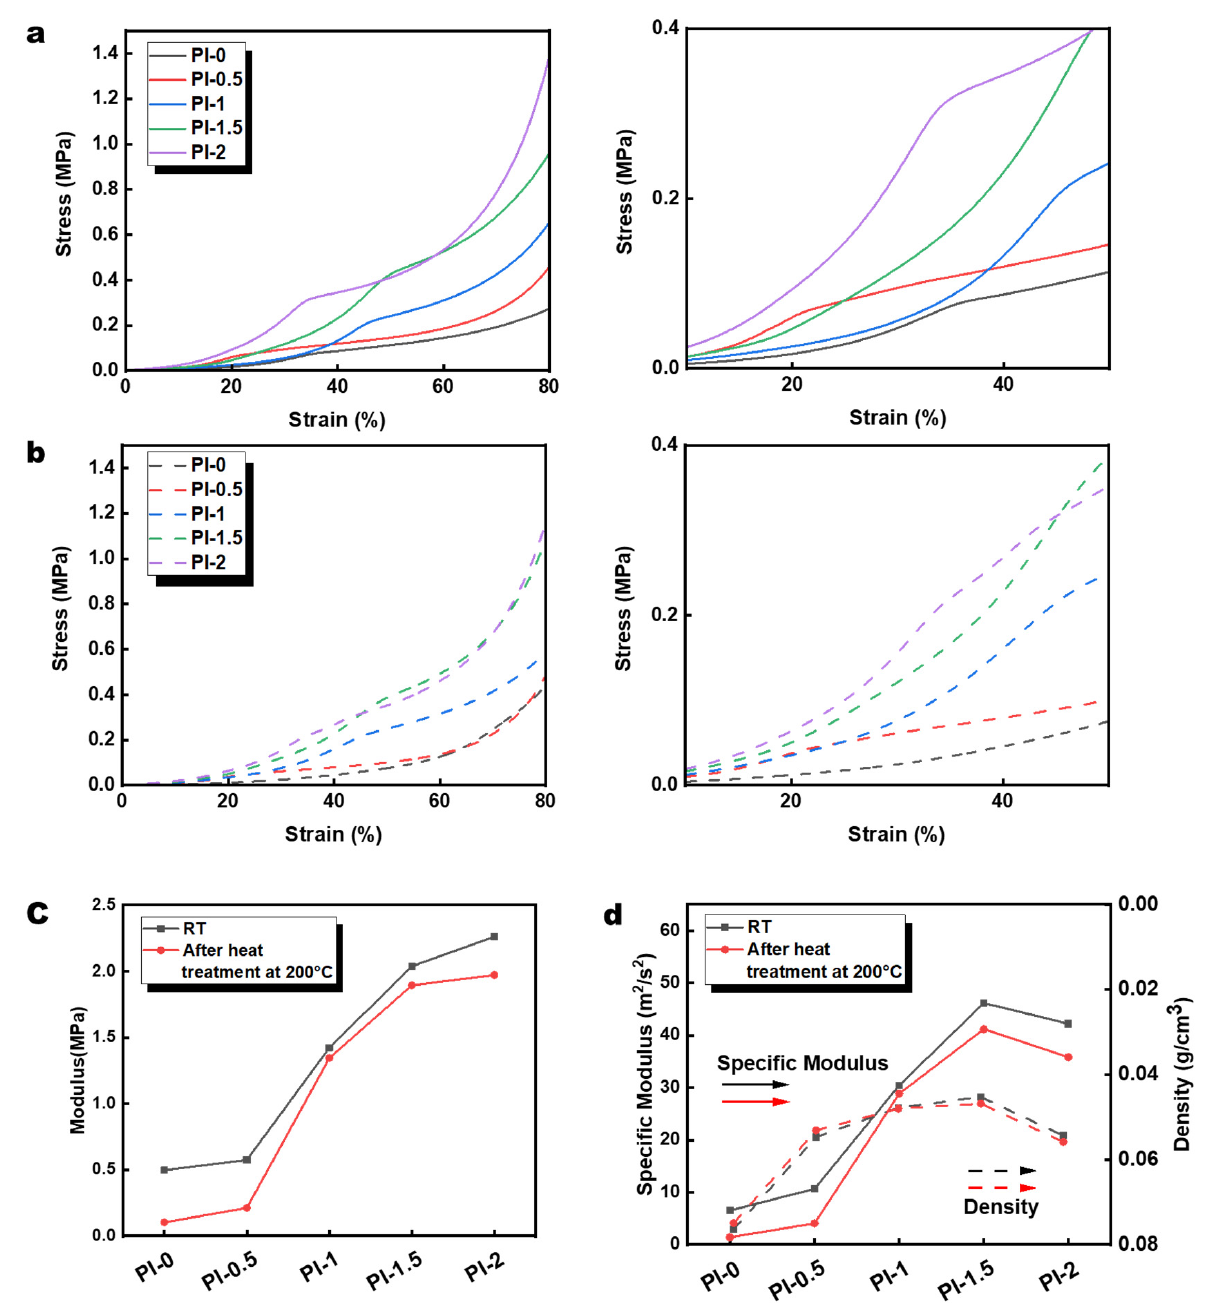
Figure 5. ( a , b ) The stress–strain curves, ( c ) Young’s moduli, ( d ) specific moduli, and densities of PI-0, PI-0.5, PI-1, PI-1.5, and PI-2.